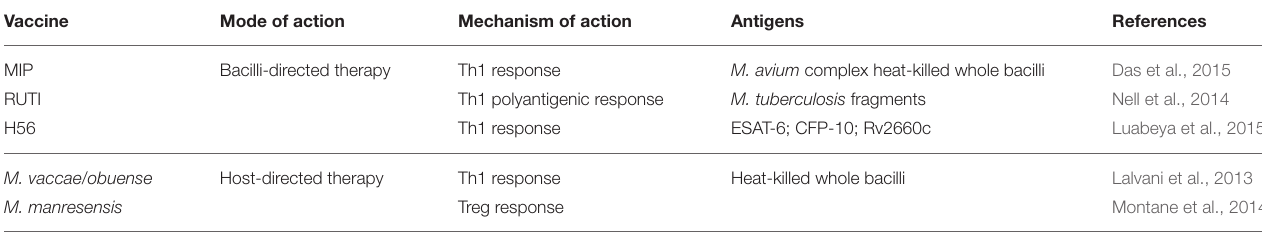
TABLE 1 | Therapeutic vaccines against tuberculosis in clinical